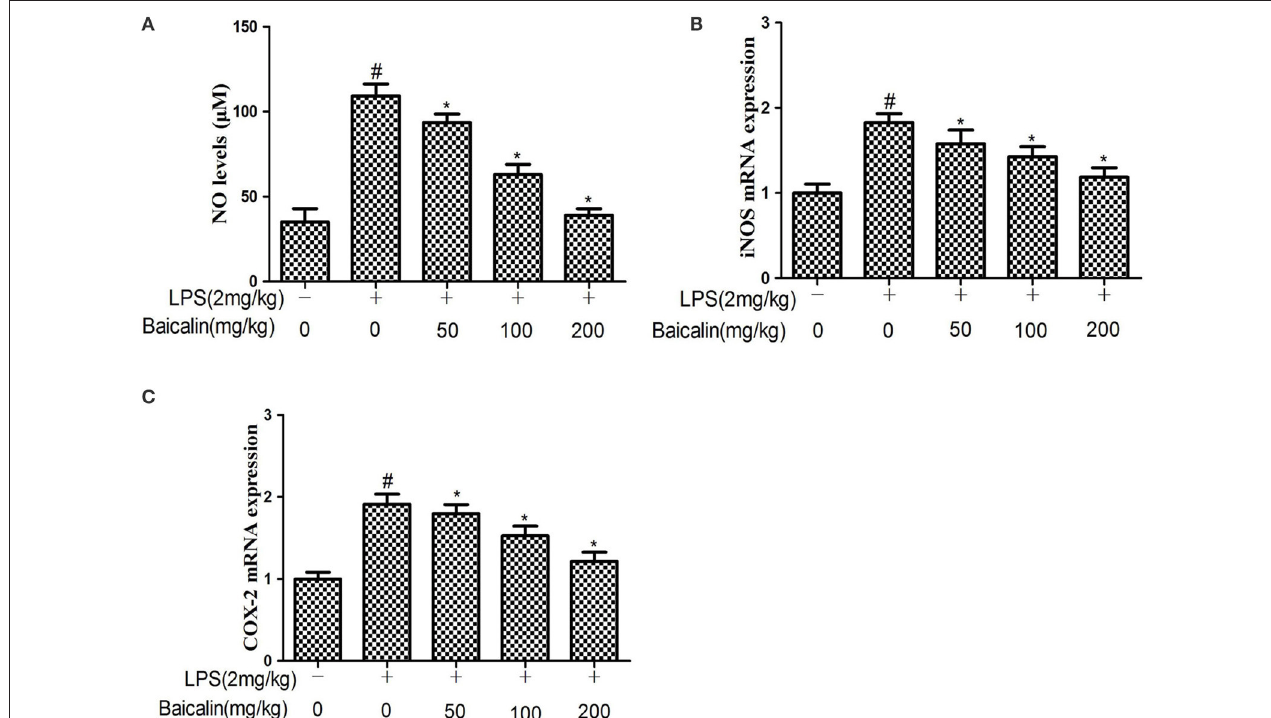
FIGURE 3 | Effects of Baicalin on LPS-induced NO levels (A) and iNOS (B) and COX-2 mRNA expression (C) in liver. Data are expressed as the mean ± SD . ( n = 10). * P < 0.05vs. LPS group; # P < 0.05vs. control group.